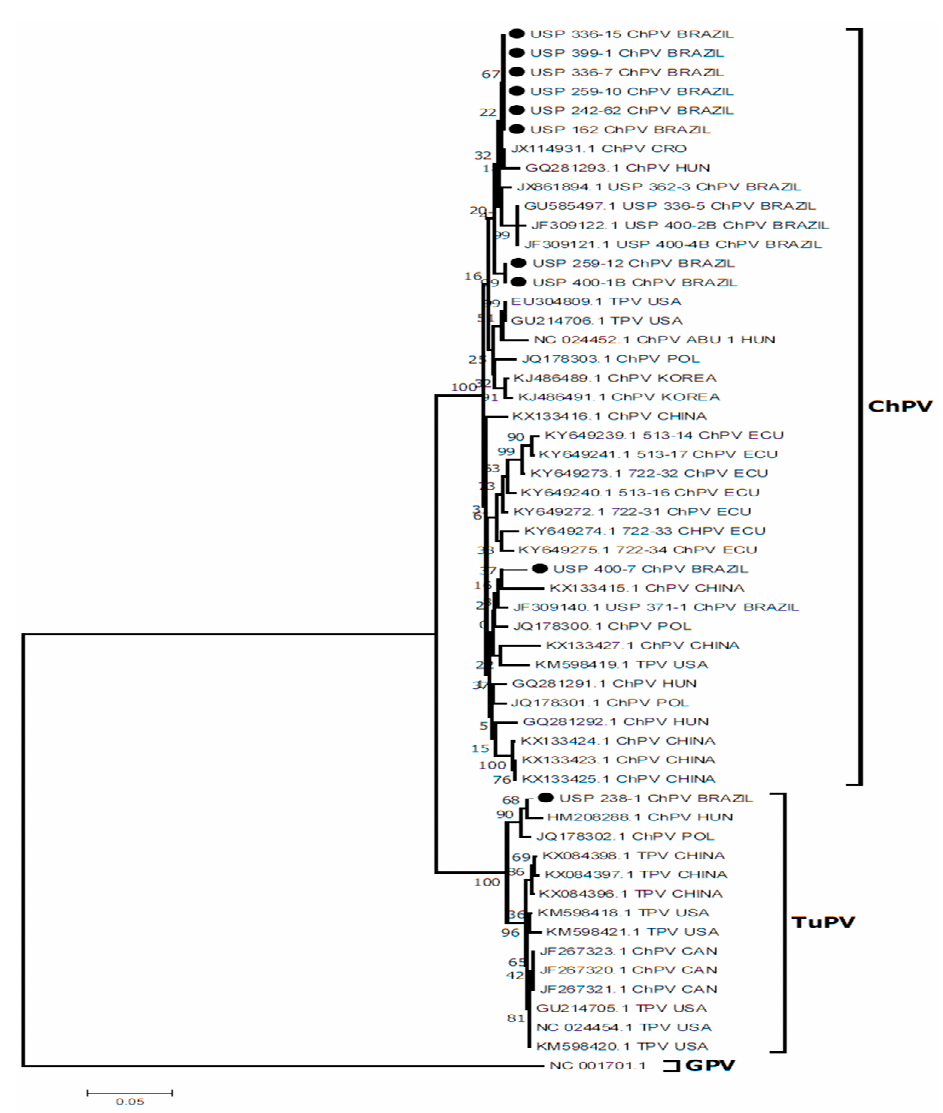
Figure 3. Phylogenetic relationships between the sequences of ChPV obtained here and other sequences of chicken parvovirus (ChPV) and turkey parvovirus (TuPV) from Brazil, Canada, China, Croatia, Ecuador, Hungary, Korea, Poland, and United States based on a part of NS gene nucleotide sequences. Sequences were aligned using the CLUSTAL W method in ClustalX2 2.1. The phylogenetic tree was constructed using MEGA 7 Software package. Numbers along the branches refer to bootstrap values for 1000 replicates. The scale bar represents the number of substitutions per site. Goose Parvovirus (GPV) was used as the outgroup. ● = Sequences obtained in this study; CAN = Canada; CRO = Croatia; ECU = Ecuador; POL = Poland; HUN = Hungary; USA = United States.